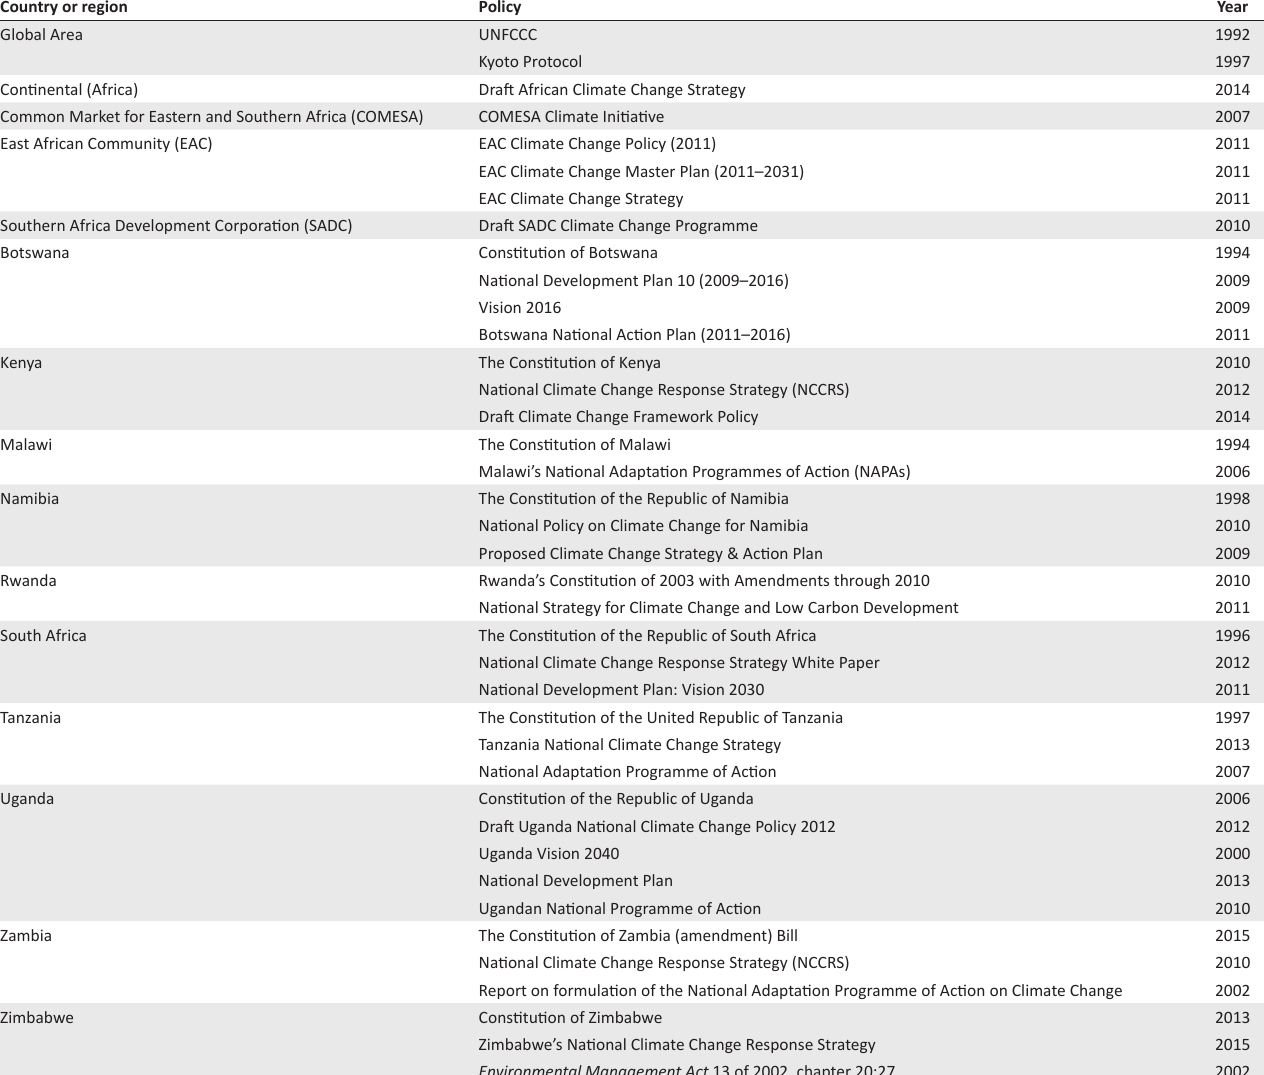
TABLE 1: Sample regions and countries’ policy documents related to climate change. Country or